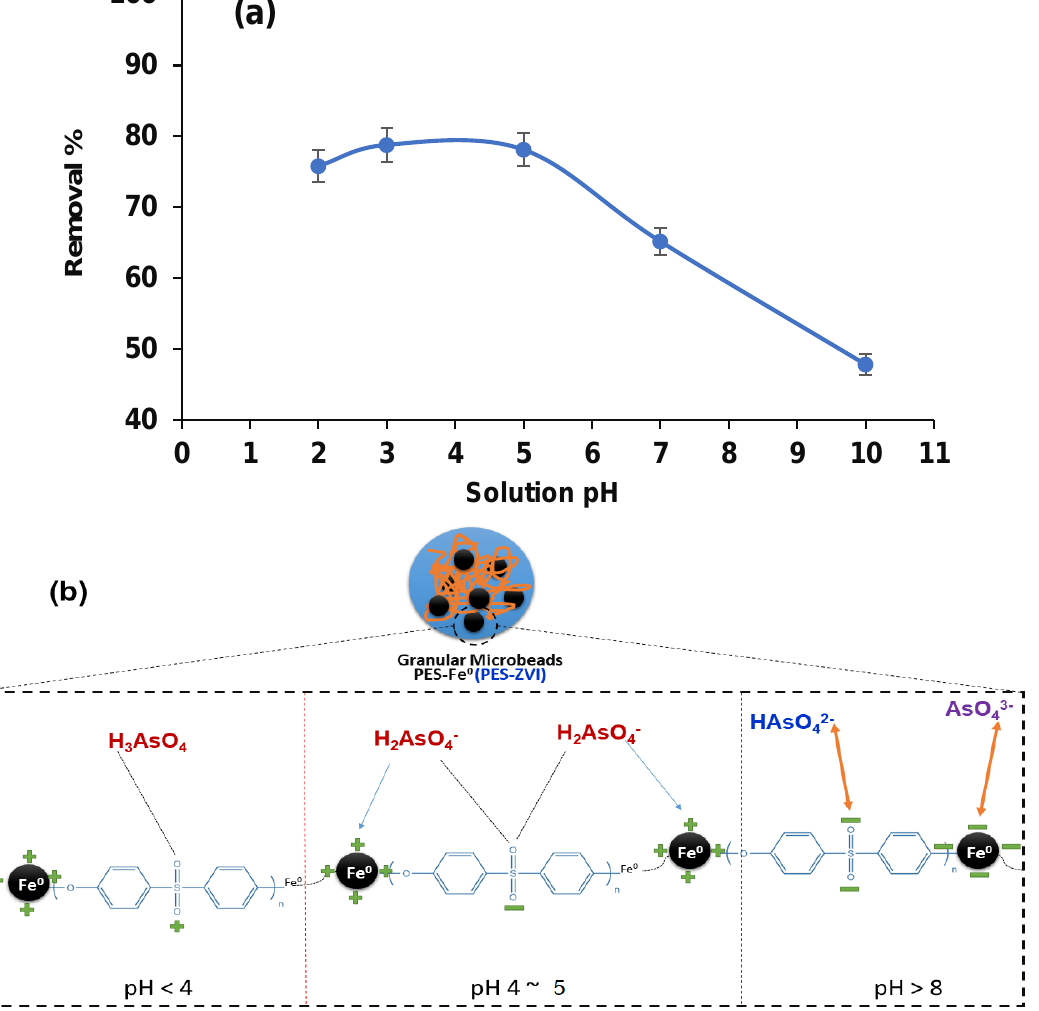
Figure 6. ( a ) The effect of pH on the removal percentage (50 mg adsorbent, 120 min reaction time, and 20 mg · L − 1 of arsenic) and ( b ) proposed adsorption mechanism at different pH values.